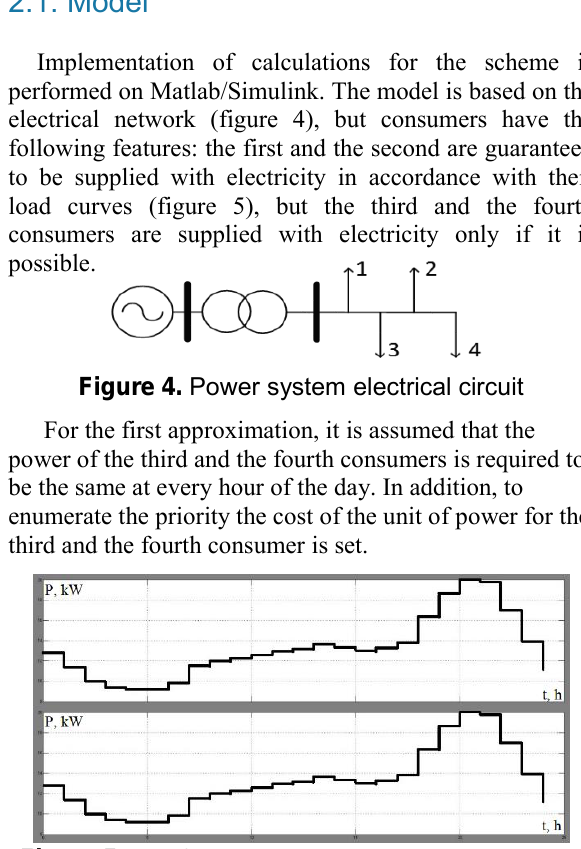
Figure 5. The first and the second consumers load curves